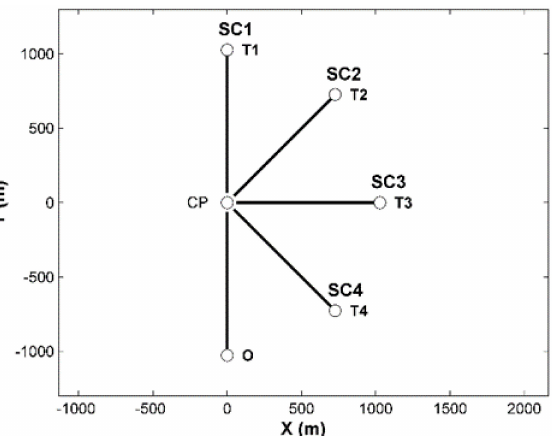
Figure 3. Four scenarios designed for evaluating the estimated performance of critical latency.